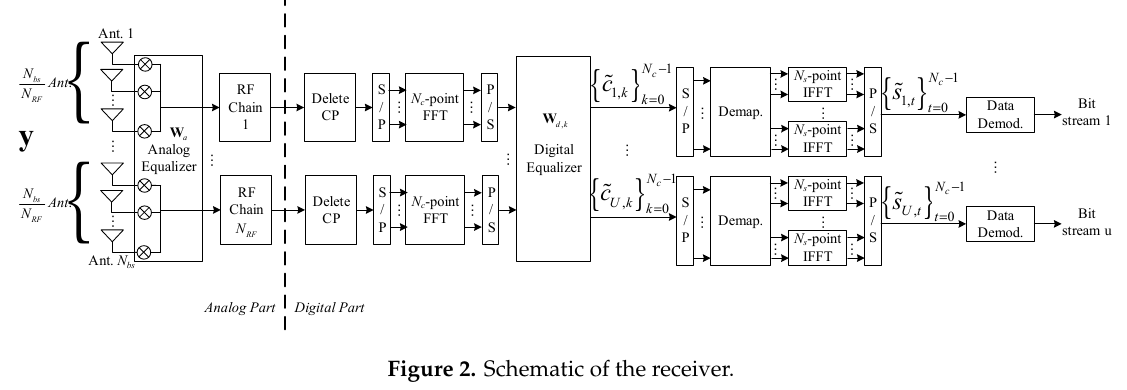
Figure 2. Schematic of the receiver.